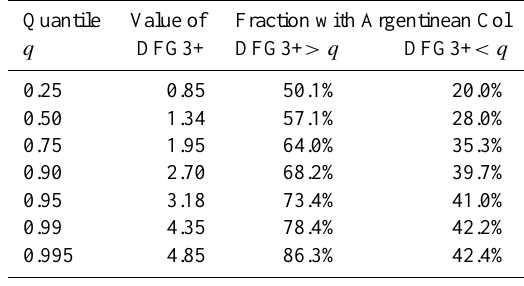
Table 1. DFG3+ quantiles and the fraction of events in which the AC is present in R for the events with DFG 3 + above or lower than the quantile value.